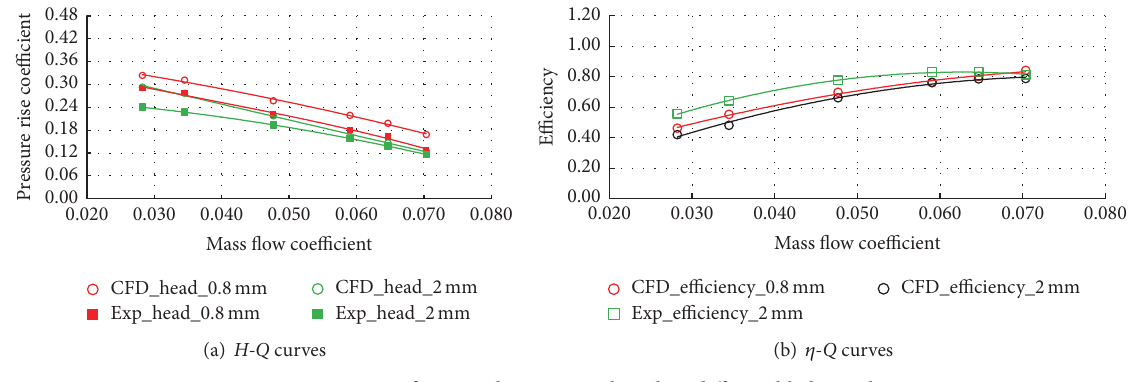
Figure 7: Comparison of H - Q and 𝜂 - Q curves based on different blade tip clearances.